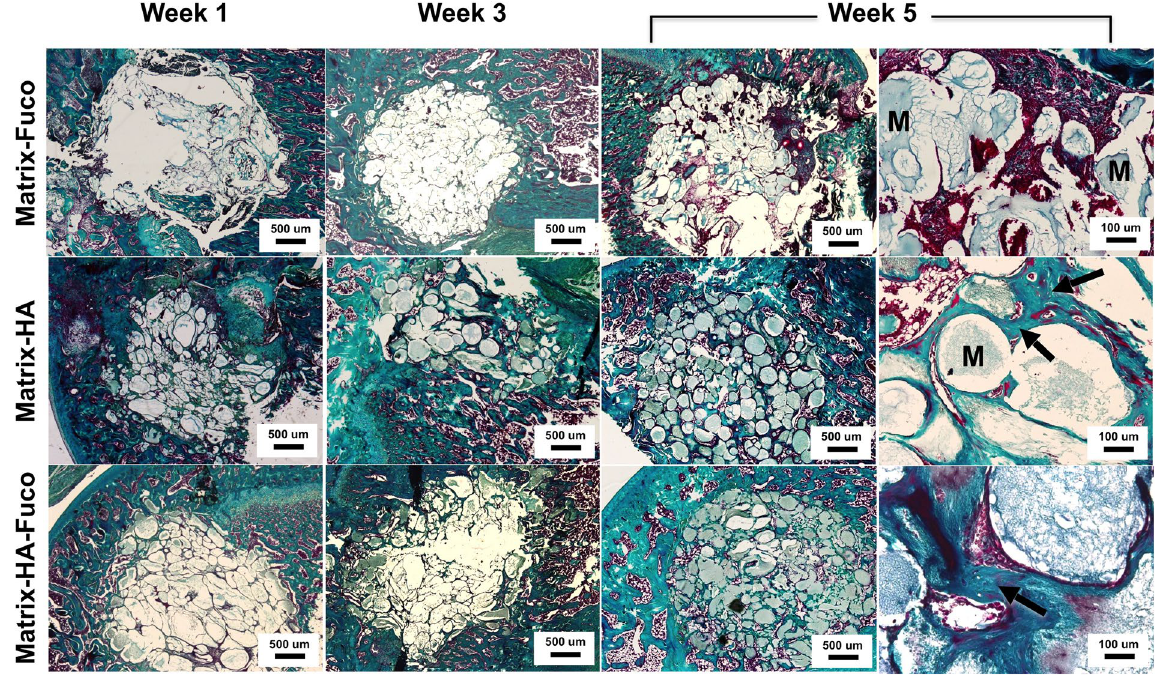
Figure 3. Representative images of histological staining of the bone defects that received the biomaterials at week 1, 3 and 5. Decalcified sections were stained with Masson’s Trichrome. Increase of osteoid, mineralized bone tissue and osteocytes are visible over time (arrows on the magnification images) around the beads of Matrix-HA and Matrix-HA-Fuco, especially at week 5. M: